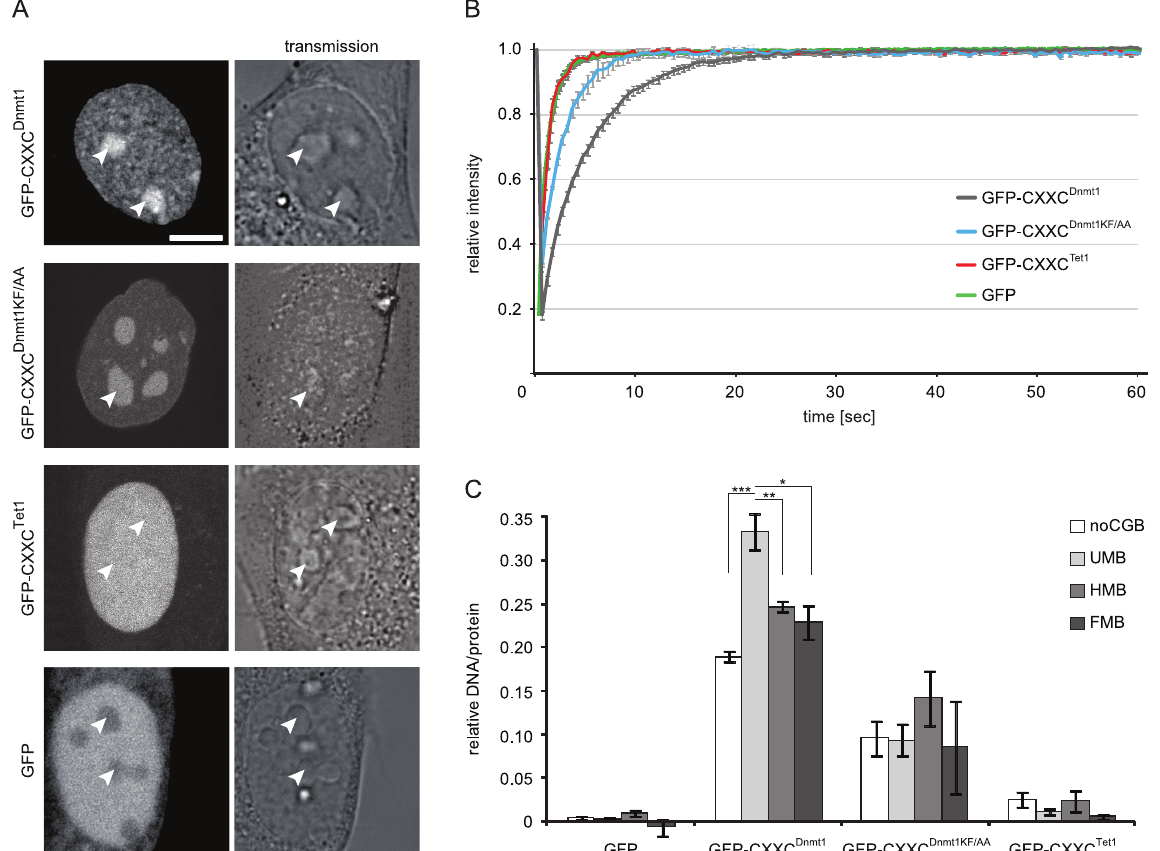
Figure 2. Properties of isolated Dnmt1 and Tet1 CXXC domains. ( A–B ) Subcellular localization (A) and binding kinetics (B) of GFP-CXXC Dnmt1 , GFP-CXXC Dnmt1KF/AA , GFP-CXXC Tet1 and GFP in mouse C2C12 myoblasts. Localization and binding kinetics were independent from the cell cycle stage (Figures S2 and S5 in File S1). Arrowheads in (A) point to nucleoli. Scale bar: 5 m m. Binding kinetics were analyzed by FRAP. ( C ) DNA binding specificity of the Dnmt1 and Tet1 CXXC domains. GFP, GFP-CXXC Dnmt1 , GFP-CXXC Dnmt1KF/AA and GFP-CXXC Tet1 were pulled down from extracts of transiently transfected HEK293T cells and incubated with fluorescent DNA substrates containing no CpG site or one central un-, hemi- or fully methylated CpG site in direct competition (noCGB, UMB, HMB, FMB, respectively). Shown are the mean DNA/protein ratios and corresponding standard errors from 5 (GFP), 4 (GFP-CXXC Dnmt1 and GFP-CXXC Dnmt1KF/AA ) and 2 (GFP-CXXC Tet1 ) independent experiments. * P =0.01; ** P =0.007; *** P =0.001.